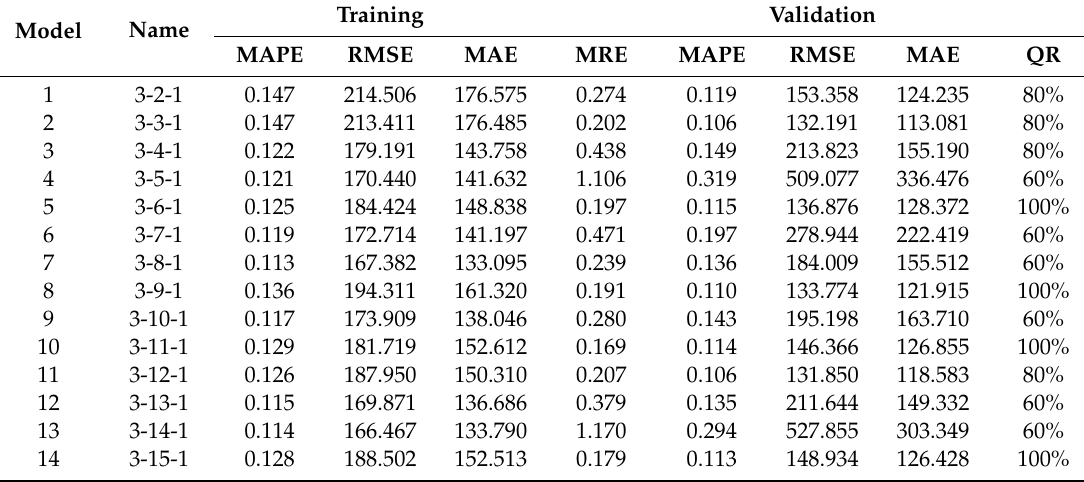
Table 6. With the first, second and third principal components as input, the performance of Elman networks with di ff erent hidden layer